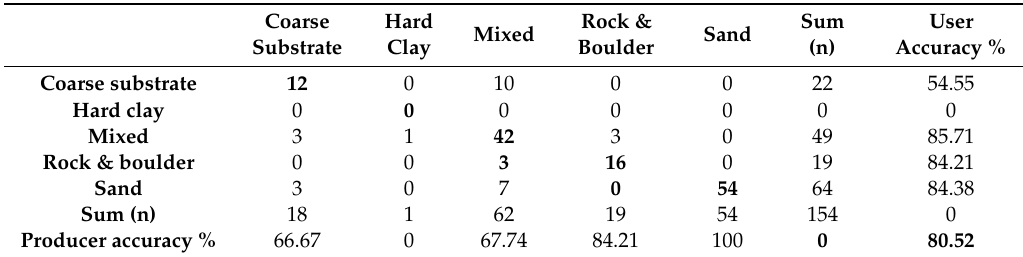
Table A3. Observed vs. predicted confusion matrix for reclassified HUB 3 map using the validation data set (n = 154).